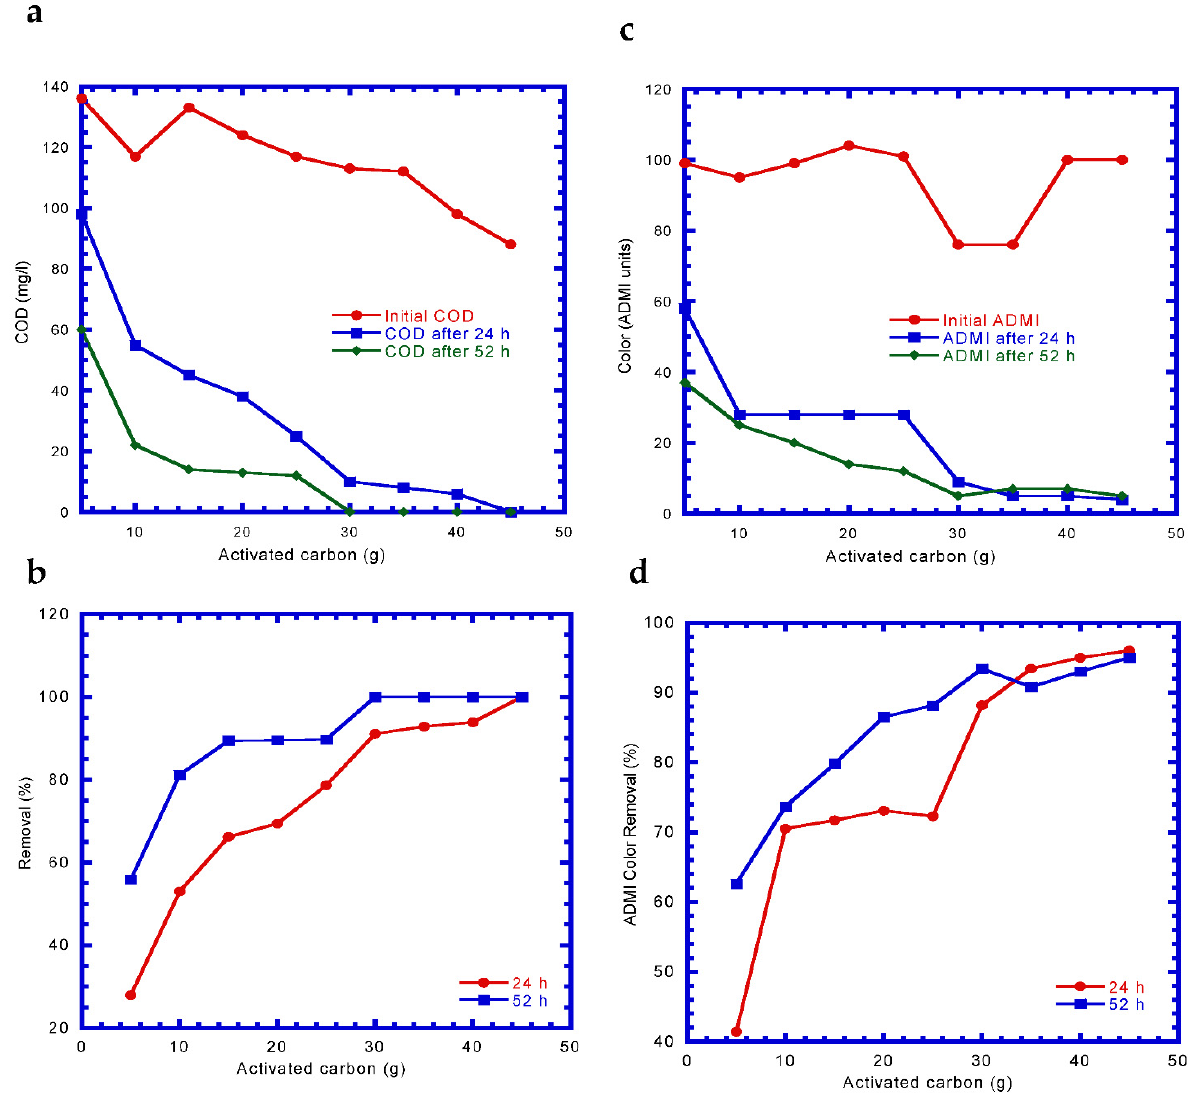
Figure 2. Variation of chemical oxygen demand (COD) and American Dye Manufactures Institute (ADMI) at various activated carbon weights: ( a ) COD reduction, ( b ) COD removal, ( c ) ADMI reduction, and ( d ) ADMI removal.